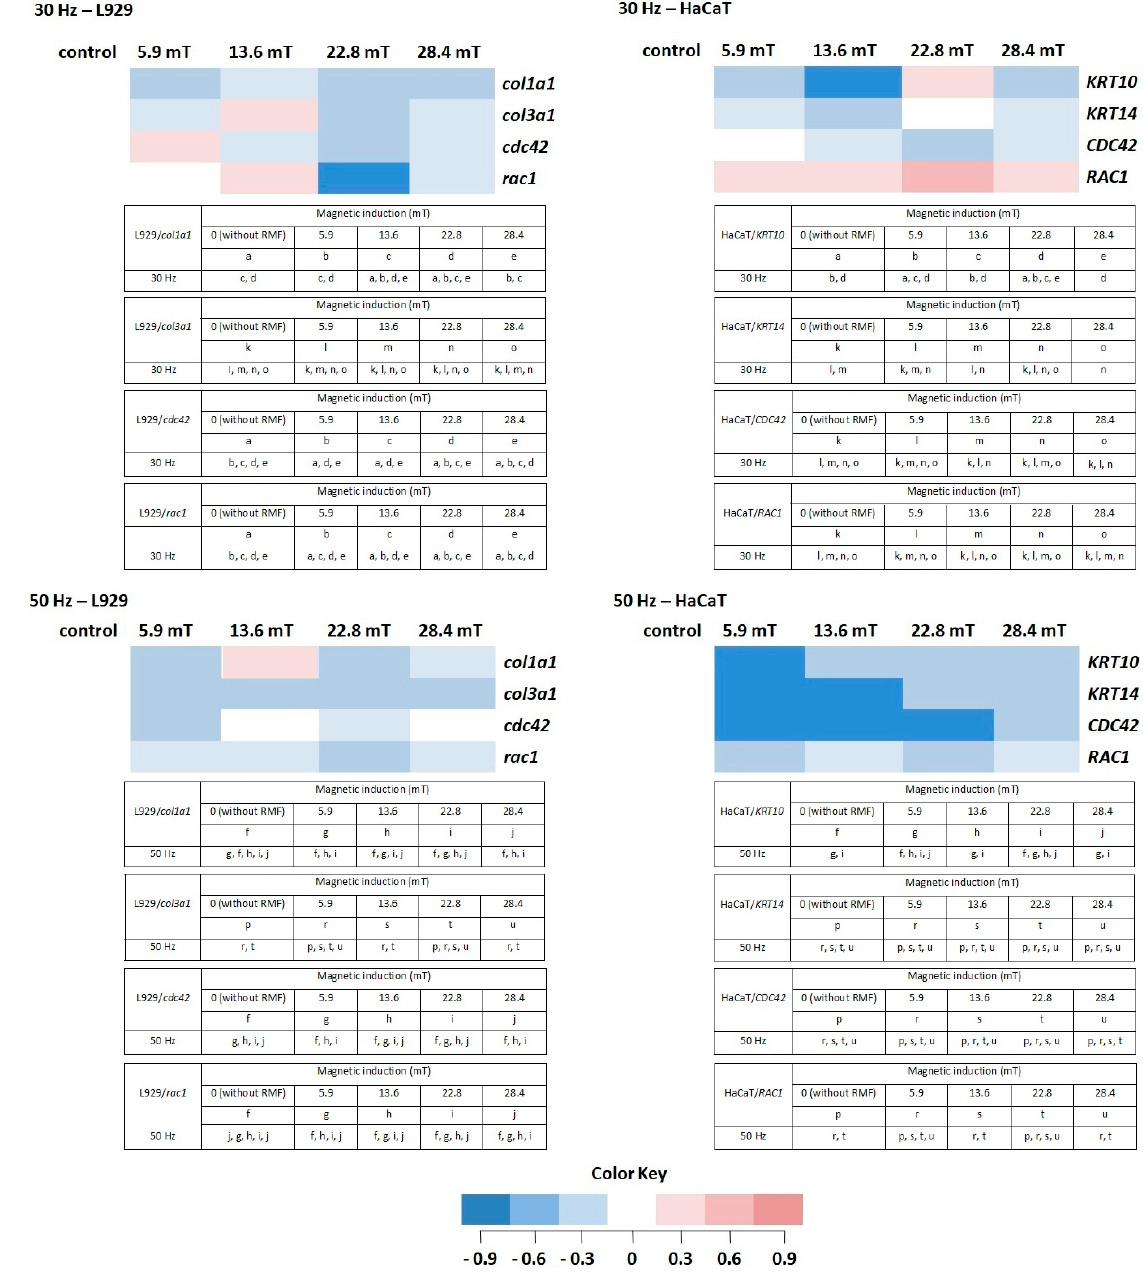
Figure 8. The profile of gene (involved in the wound healing process) expression in L929 and HaCaT cell cultures after exposure to RMF (all samples were compared to control; p -values < 0.05 were considered significant and were represented by small letters). Differneces in gene expression level represented by different colors: expression level equal to control—white; lower expression level—light blue; medium lower expression level—blue; the lowest expression level—drak blue; higher expression level—light red; medium higher expression level—red; the highest expression level—dark